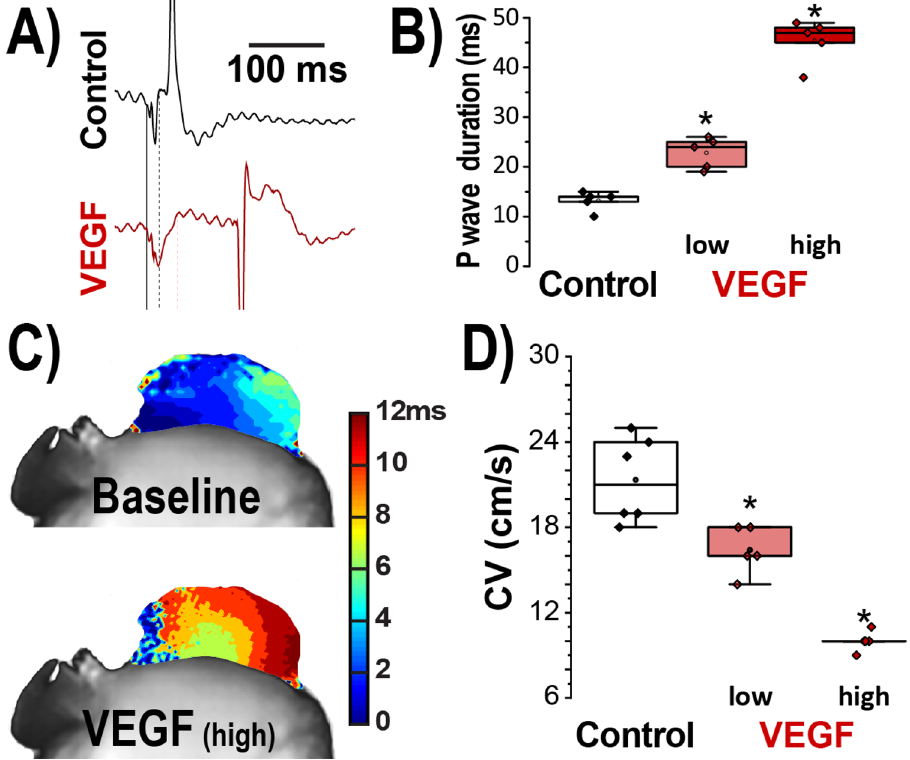
Figure 1. Acute effects of VEGF on atrial conduction. ( A ) Representative volume-conducted ECGs. ( B ) Summary plots of P wave duration (n = 5/group; * p < 0.05 vs. control). ( C ) Representative isochrone maps of left atrial activation. ( D ) Summary plots of CV (n = 5/group; * p < 0.05 vs.